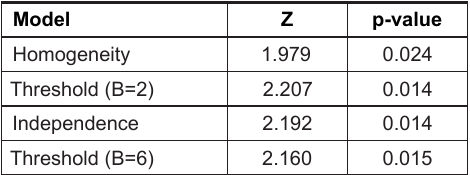
Table 15. Tests for randomness of collared caribou for the Bluenose-West 2009 data